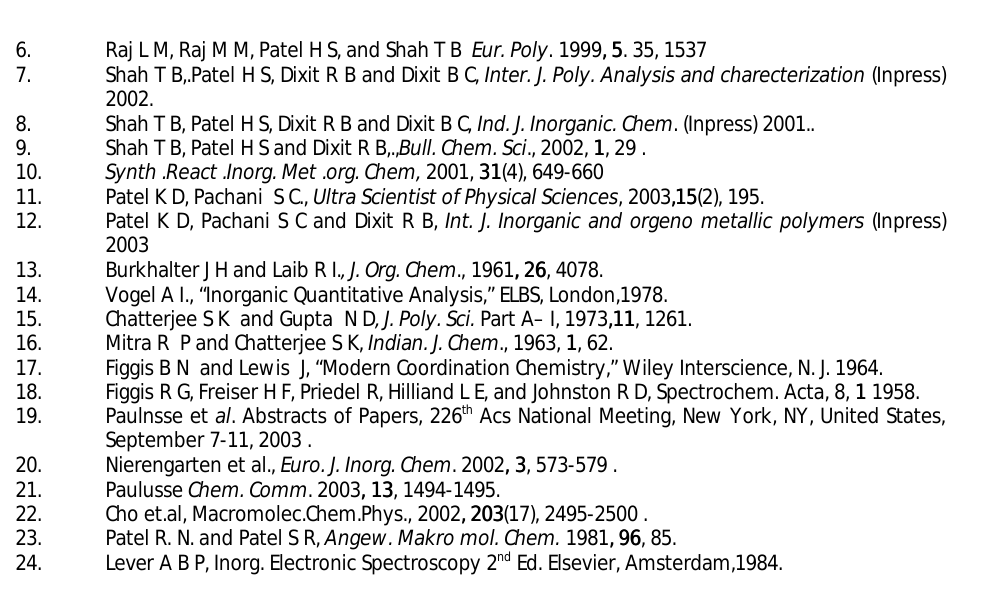
Figgis B N and Lewis J, “Modern Coordination Chemistry,” Wiley Interscience, N. J. 1964. 18. Figgis R G, Freiser H F, Priedel R, Hilliand L E, and Johnston R D, Spectrochem. Acta, 8, 11 1958.